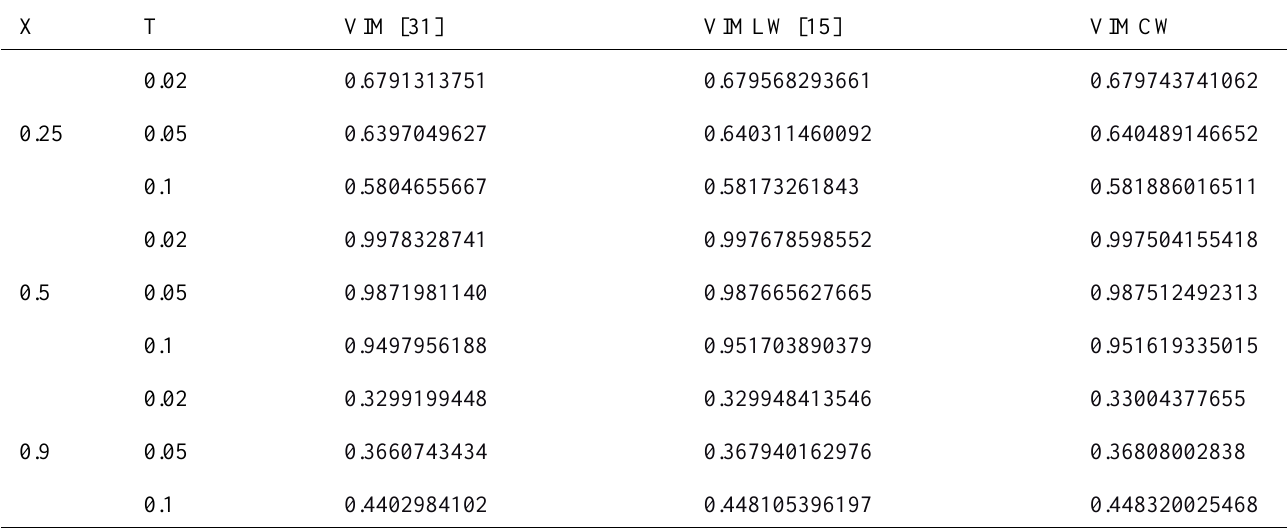
Analysis of the computed solution with different parameters, when 𝛼 = 𝛽 = 1, 𝛾 = 0.01 and for 𝜀 = 0.001